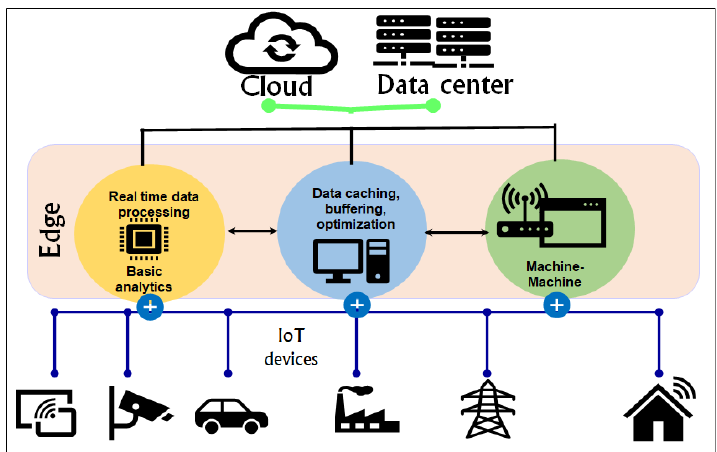
Figure 13. Workflow diagram of the edge